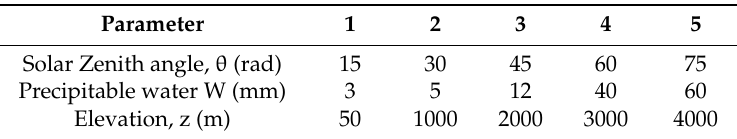
Table 4. Levels of solar Zenith angle, Precipitable water, and Local elevation applied as input in SMARTS2 to simulate at-surface solar radiation